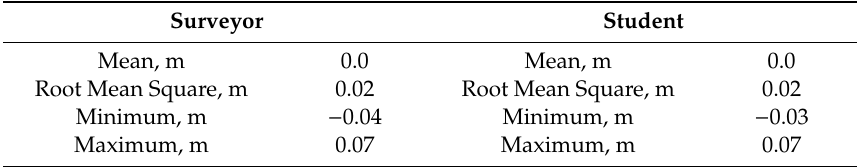
Table 2. Comparative analysis of experienced and inexperienced topographic data collection.